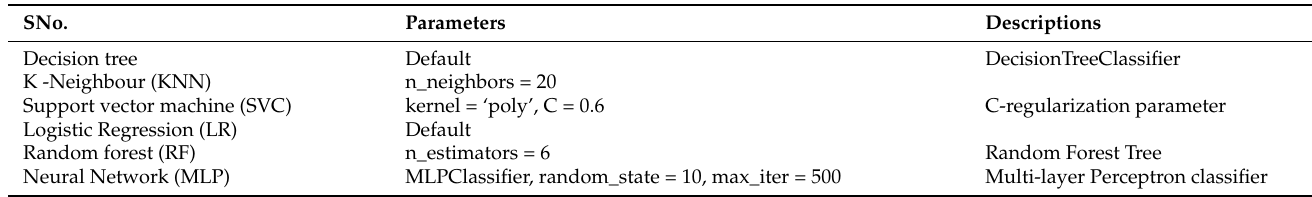
Table 11. Parameters specification used for each